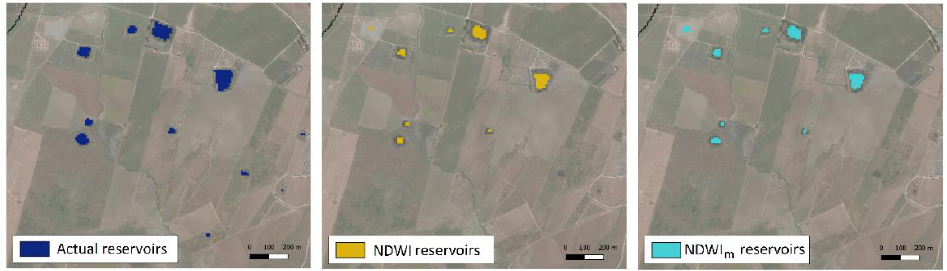
Figure 10. Comparison between the map of actual reservoirs and the maps of reservoirs predicted by the NDWI and NDWI m (17 June 2017).